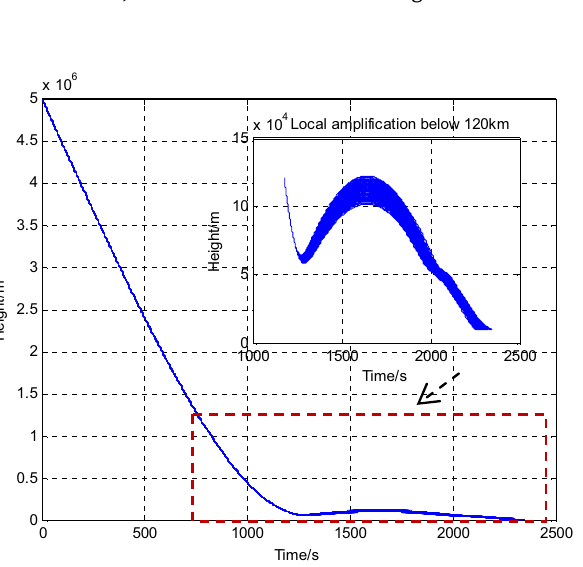
Figure 2: The height dispersion diagram in trajectory feature infor - mation base.